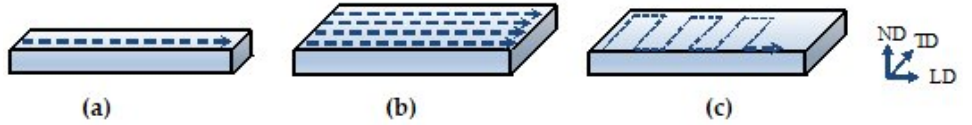
Figure 1. Deposition strategies for WAAM Ti-6Al-4V walls: ( a ) single bead, ( b ) parallel path, ( c ) oscillation path (LD = longitudinal direction (torch movement direction), ND = normal direction, TD = transverse direction) .